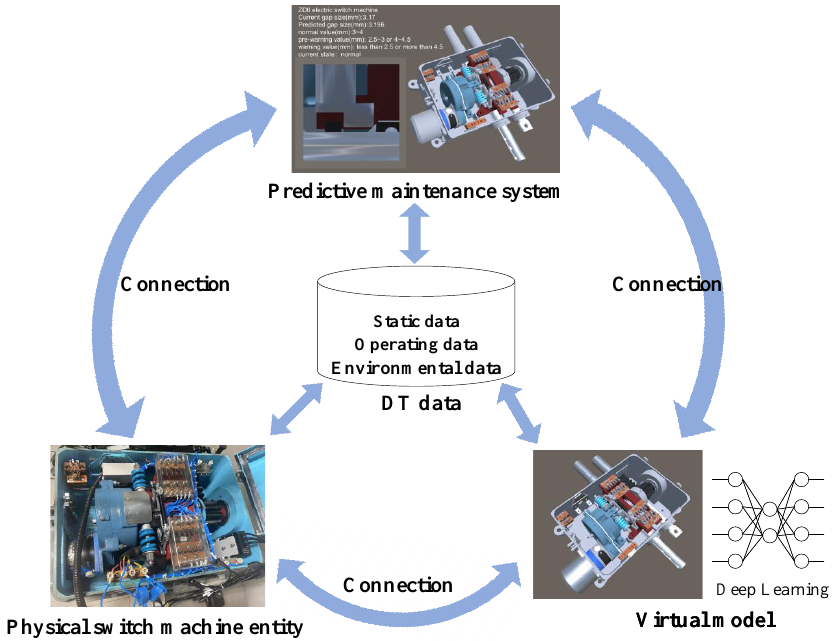
Figure 1. DT structure of the switch